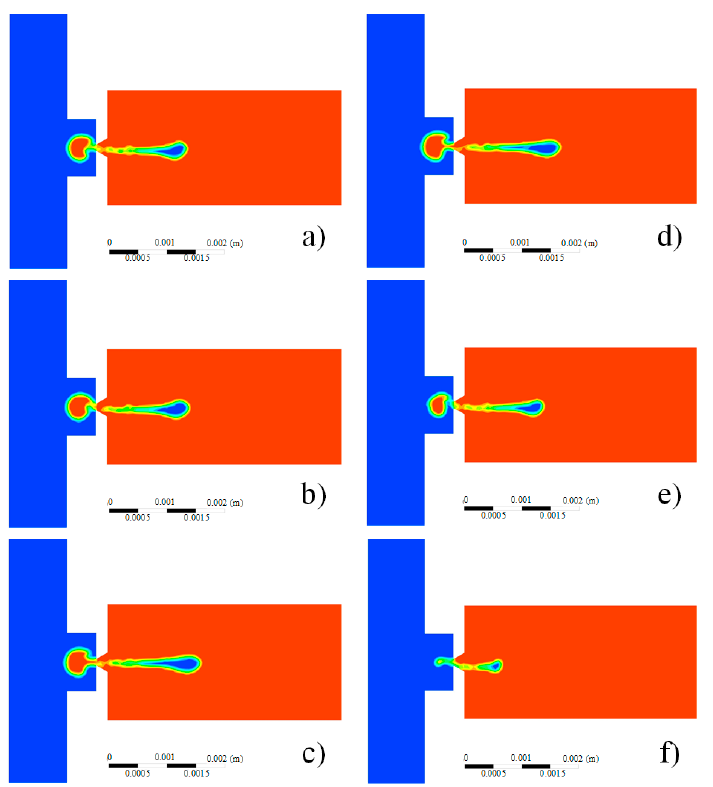
Figure 11. The injection status varies with different duty ratios: ( a ) α = 0.25; ( b ) α = 0.35; ( c ) α = 0.5; ( d ) α = 0.6; ( e ) α = 0.75; ( f ) α = 0.99.